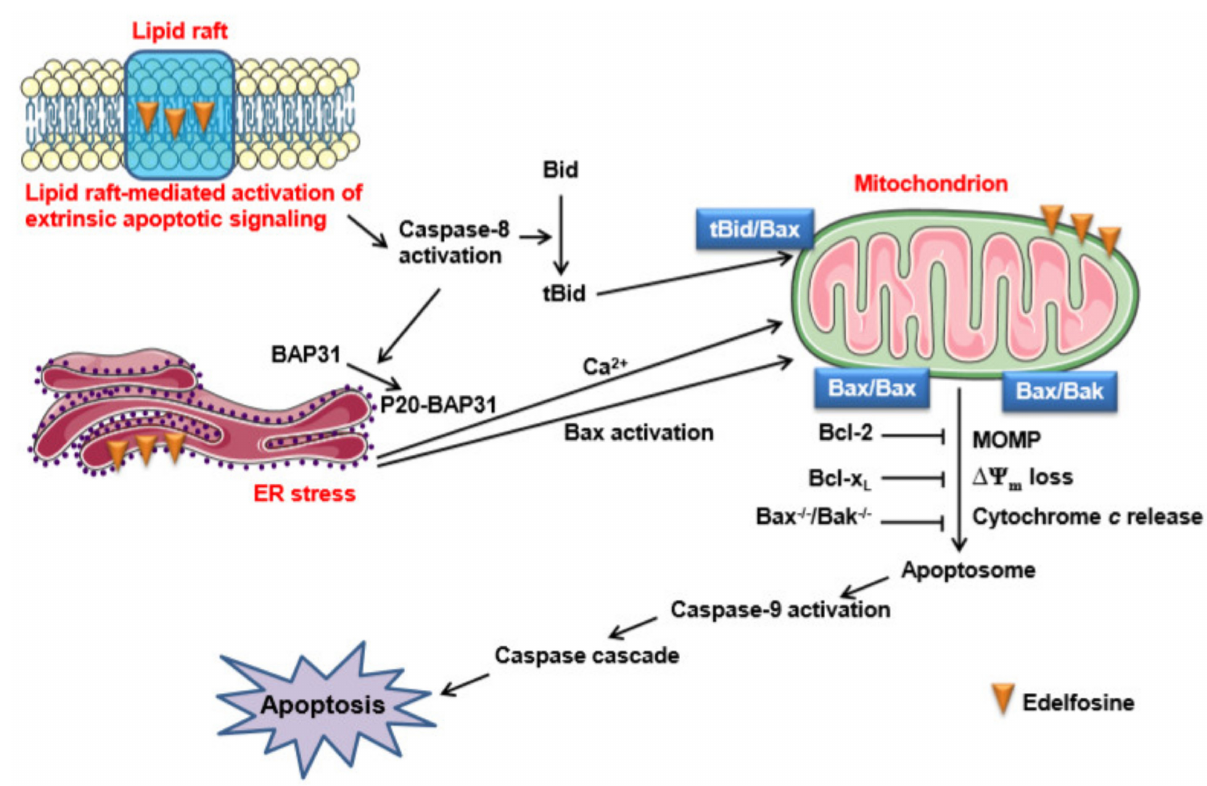
Figure 2. Schematic model of the involvement of plasma membrane lipid rafts, ER and mitochondria in edelfosine-induced apoptosis in cancer cells. Protection of mitochondria by Bcl-2 or Bcl-xL overexpression, or by Bax/Bak double knock-out (Bax -/- /Bak -/- ), prevents cell death, indicating that the apoptotic signals derived from plasma membrane and ER converge on mitochondria. See text for details. MOMP, mitochondrial outer membrane